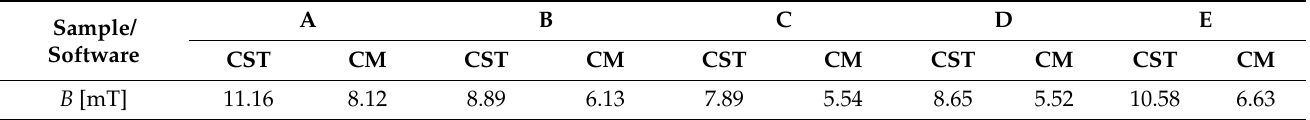
Table 2. The maximal value of B-field at evaluation points in CST and COMSOL in control coil. Sample/